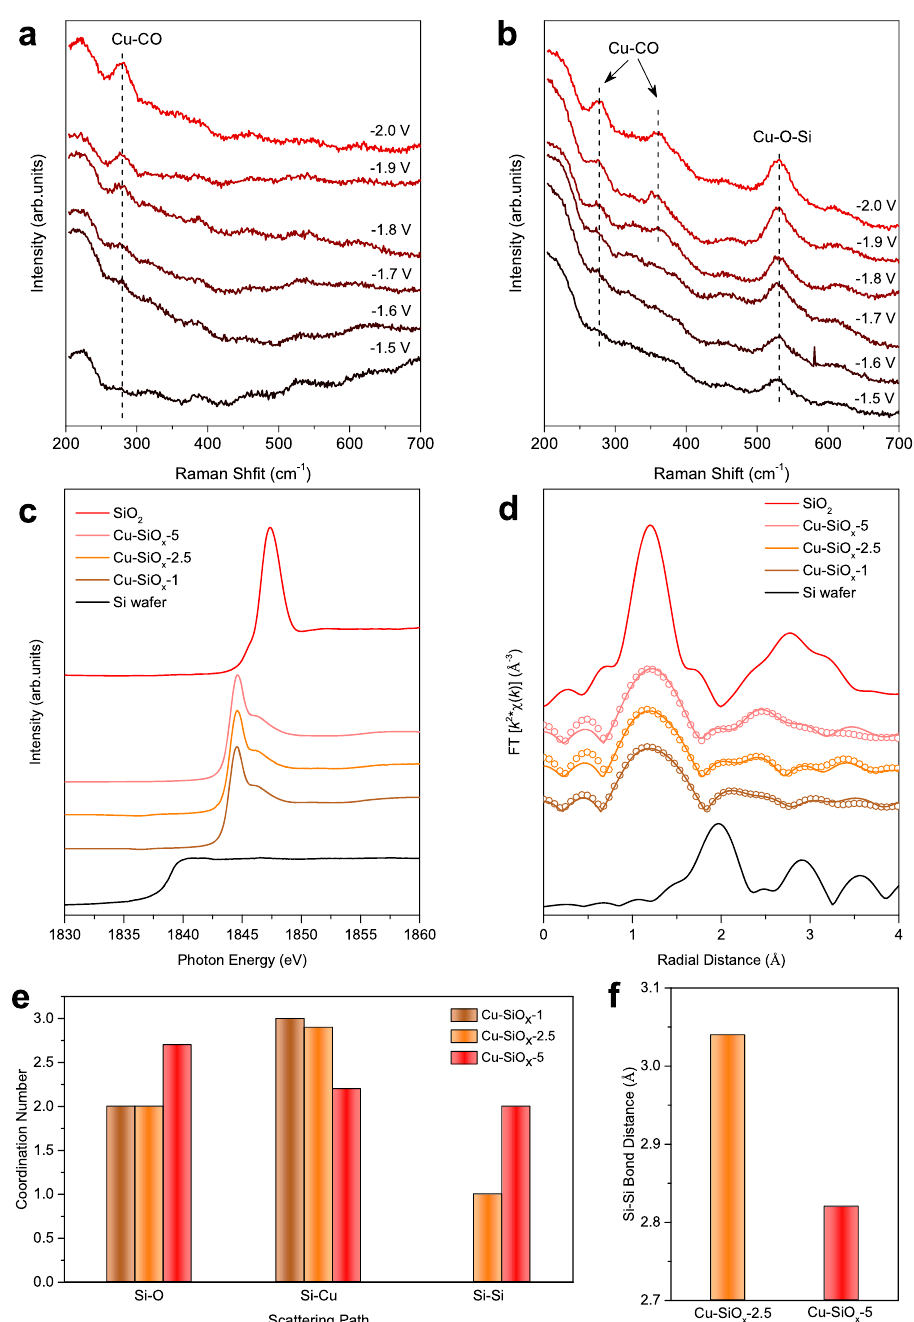
Fig. 4 Spectroscopy studies of the Cu-SiO x catalysts. a , b In-situ Raman spectra of the bare Cu ( a ) and Cu-SiOx-2.5 ( b ) catalysts at a cell potential range of − 1.5 ~ − 2.0 V. Current density recorded at each condition is listed in Supplementary Table 4. c Ex-situ Si K-edge XANES spectra of different Cu-SiO x catalysts and the Si standards (i.e., Si wafer and SiO 2 ). d The Si K-edge EXAFS spectra (solid lines) and corresponding fi tting curves (open circles) of different Cu-SiO x catalysts. The Si K-edge EXAFS spectra of Si wafer and SiO 2 standards are included for comparison. e , f Simulated coordination number ( e ) and Si – Si bond distance ( f ) of different Cu-SiO x catalysts extracted from their Si K-edge EXAFS. In-situ Raman analysis was performed during CO 2 RR, whereas ex-situ Si K-edge XAS was measured upon completion of CO 2 RR at a full-cell potential of − 4.1 V in 0.1 M KHCO 3